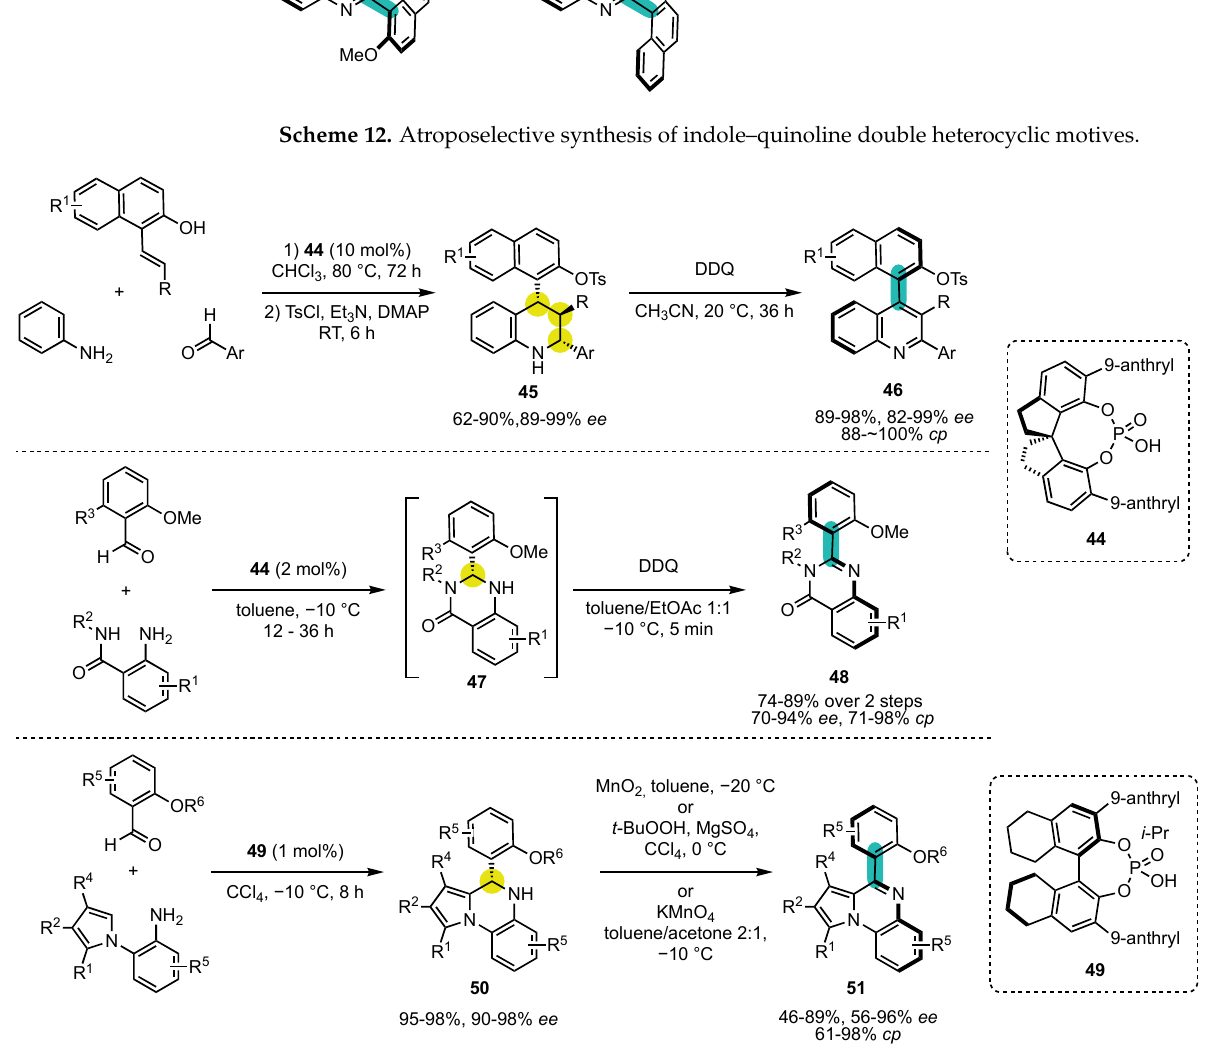
Scheme 13. Atroposelective synthesis of 4 ‐ naphthylquinolines, quinazolinones, and quinoxalines.